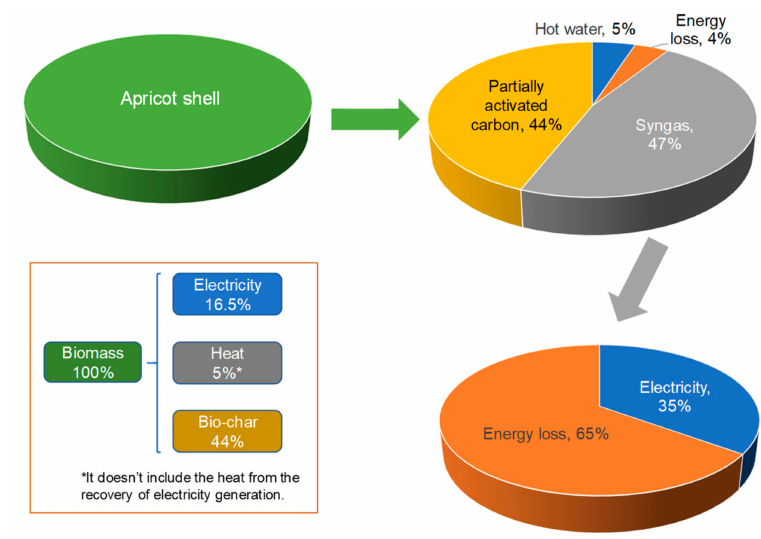
Figure 4. The typical energy converting flow of this gasification system.